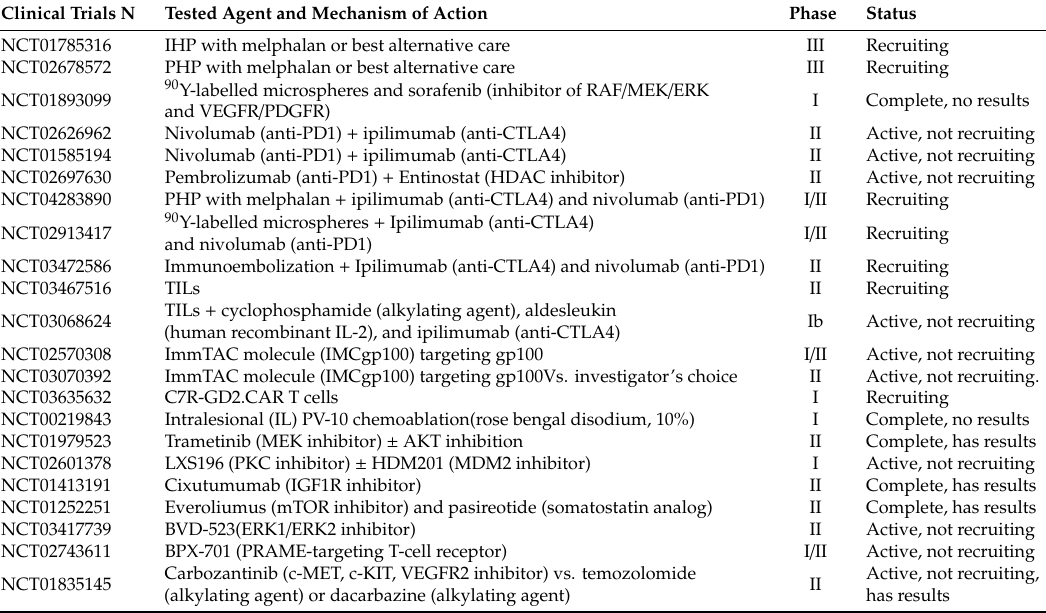
Table 3. Main ongoing trials for metastatic uveal